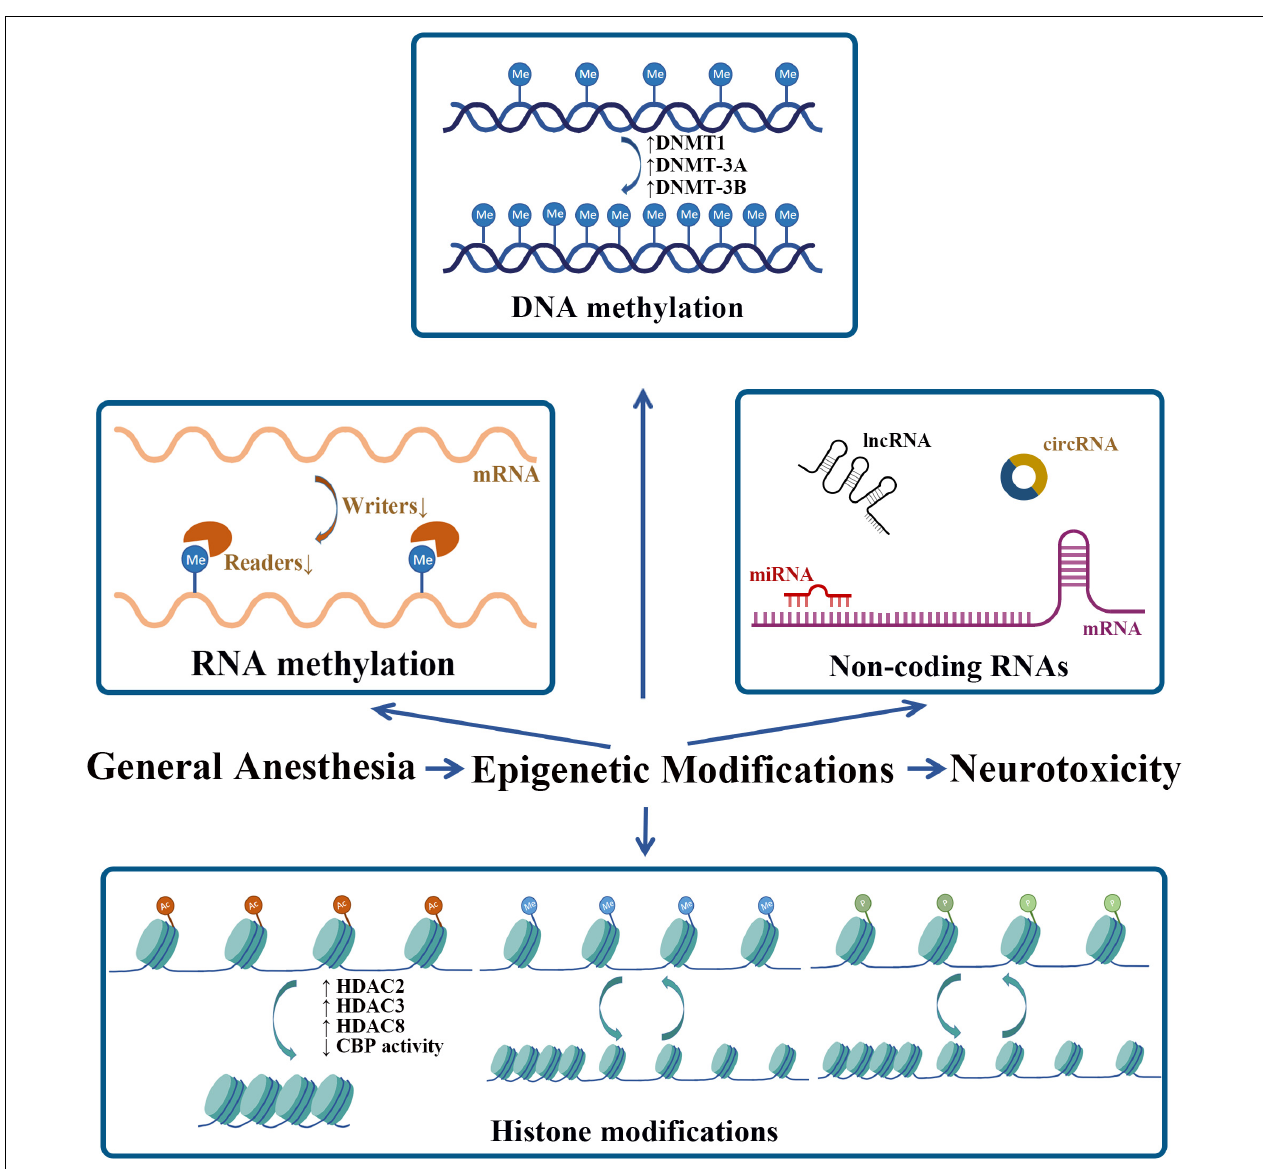
FIGURE 2 | Neonatal GA exposure-induced epigenetic modifications. Me, methyl; Ac, acetyl; P,